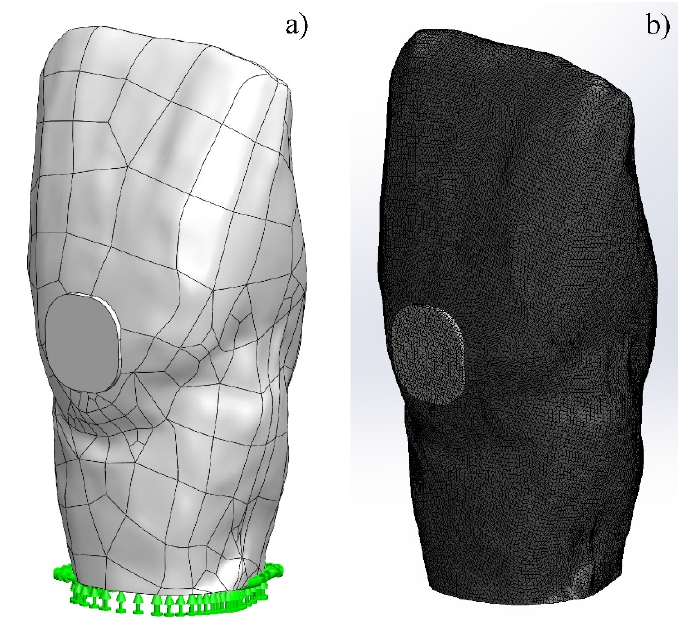
Figure 1. Virtual model of tooth 11: ( a ) fixed tooth with filling of glass-ionomer cement (GIC); ( b ) simulation mesh used.